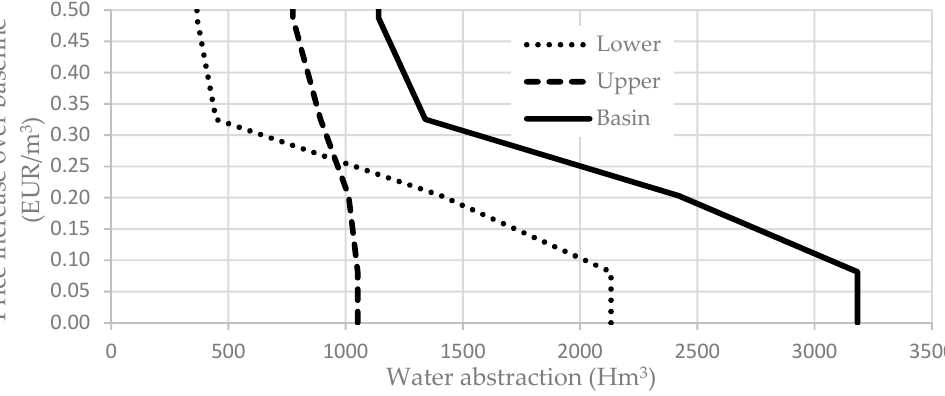
Figure 2. Elicited demand curves of water abstraction vs. water price increase (irrigation sector).